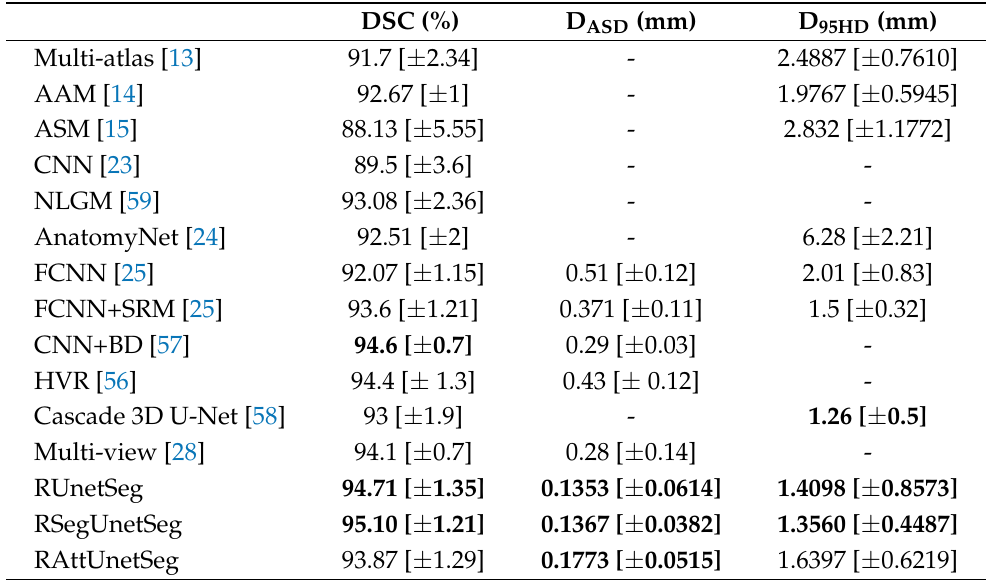
Table 3. Comparison of segmentation performance between the state-of-the-art methods and our proposed RCNNSeg approach; bold font indicates the best three performers for each